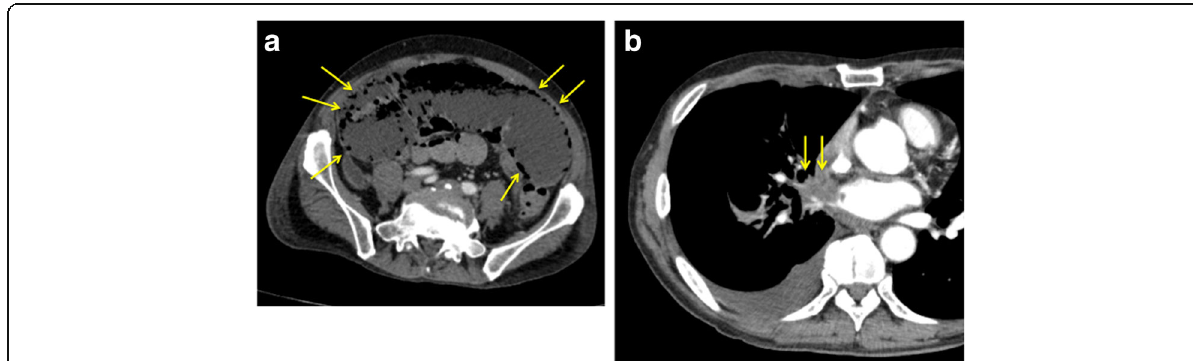
Fig. 2 a Abdominal contrast-enhanced CT scan showed diffuse intestinal and mesenteric emphysema. b A postoperative CT scan showed a lobulated 6.5-cm tumor in the right lung had directly invaded the inferior pulmonary vein and left